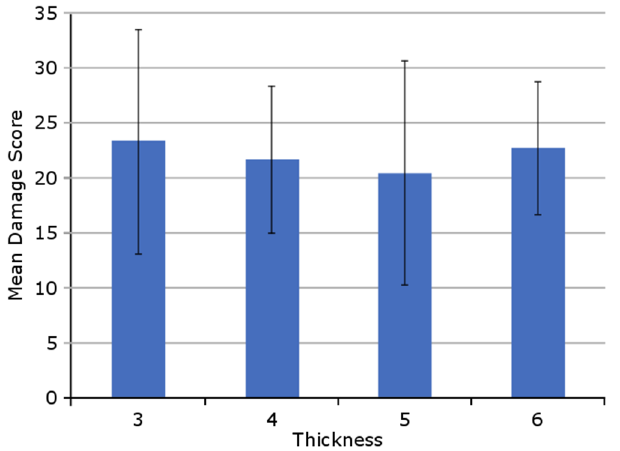
Figure 4. The distribution of the mean total damage score for the four inlay sizes (n = 47).